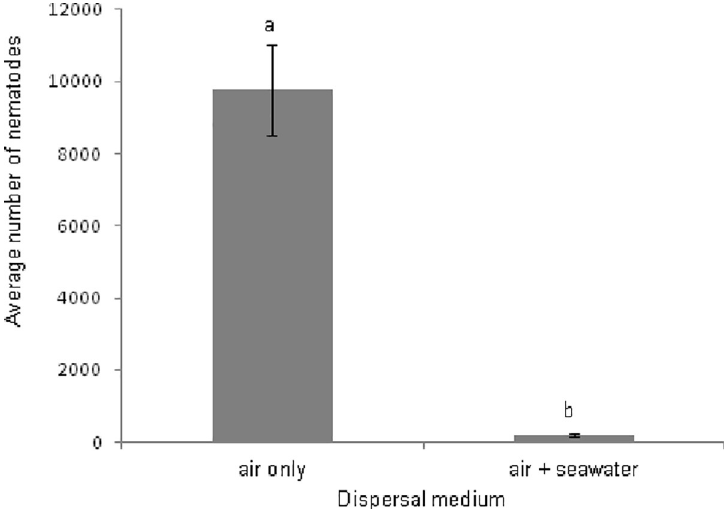
Fig 4. Average numbers of nematodes (mean ± SE) in differently positioned boxes of the field experiment, which could be reached only through the air (‘air only’ boxes) or through the air and the water column (‘air + seawater’ boxes). Letters indicate significant differences between treatments.